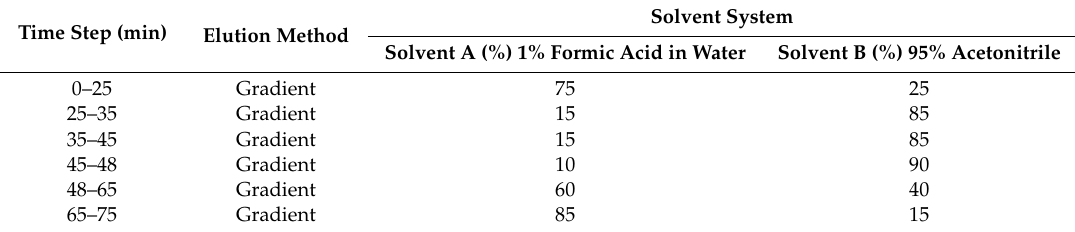
Table 2. Gradient elution for the HPLC–DAD mobile phase solvent